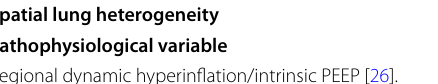
Table 2 Pathophysiology of COPD as assessed by EIT Spatial lung heterogeneity Pathophysiological variable EIT parameter Regional dynamic hyperinflation/intrinsic PEEP [26]. Heterogenous distribution of ventilation within the lungs. Temporal lung heterogeneity Pathophysiological variable EIT parameter Heterogeneity of regional start of inflation/deflation—regional differences in time constants. Regional pendelluft